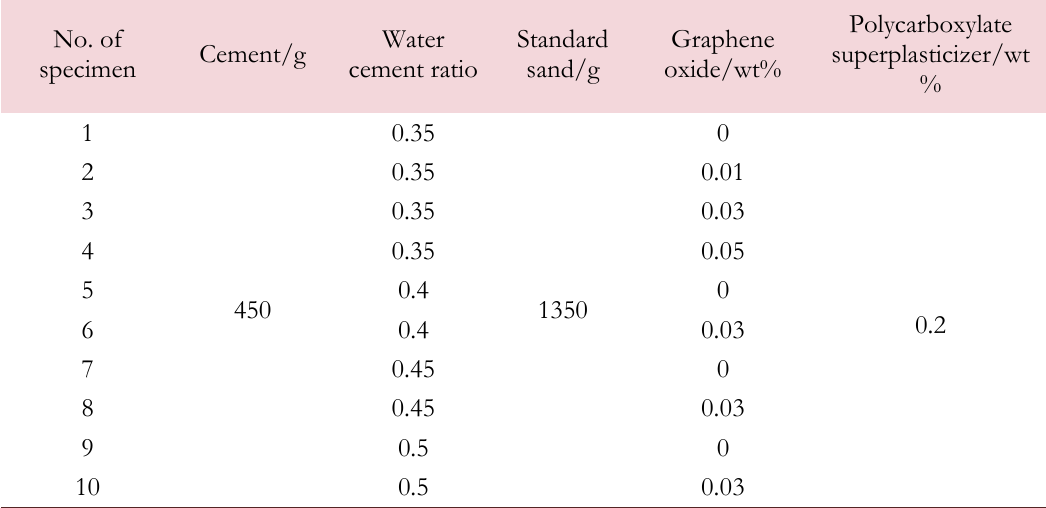
Table 1: The mix proportion of cement mortar